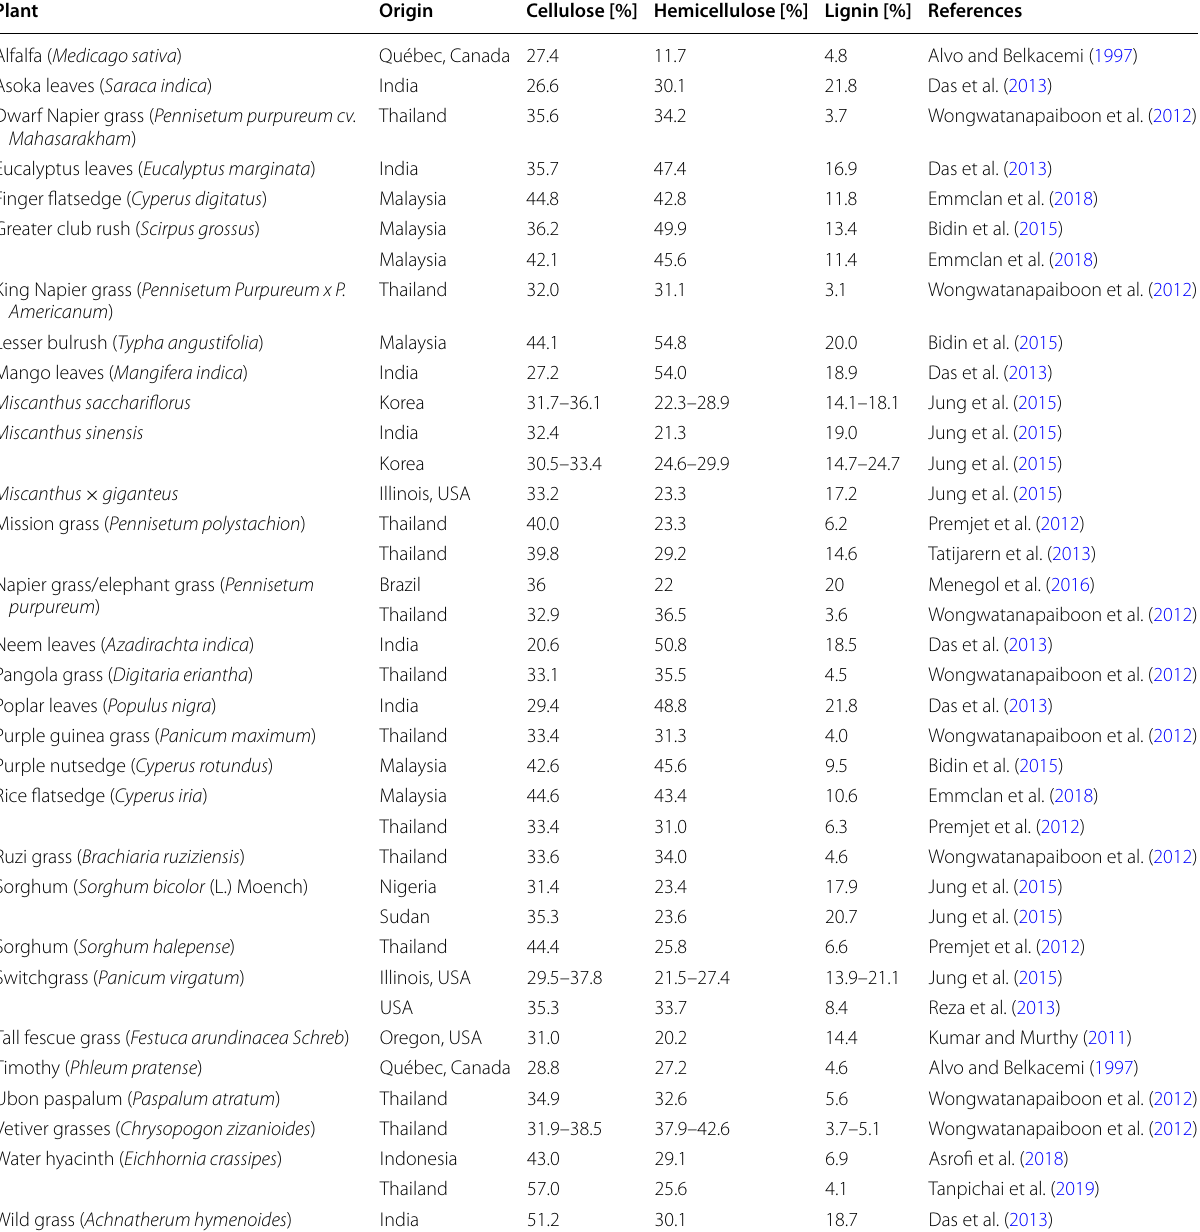
Table 1 Cellulose, hemicellulose, and lignin content from various low-lignin